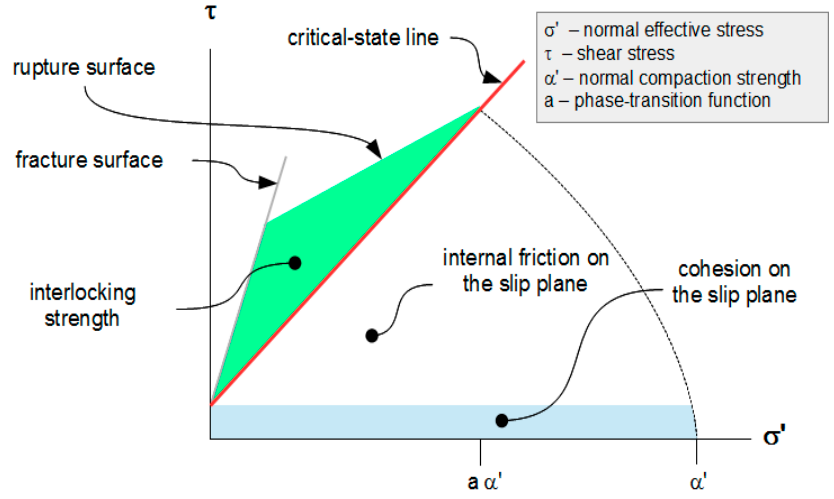
Figure 9. Projection of rupture surface for shearing mode ω = 1/2 and coherence threshold α 0 ’ =